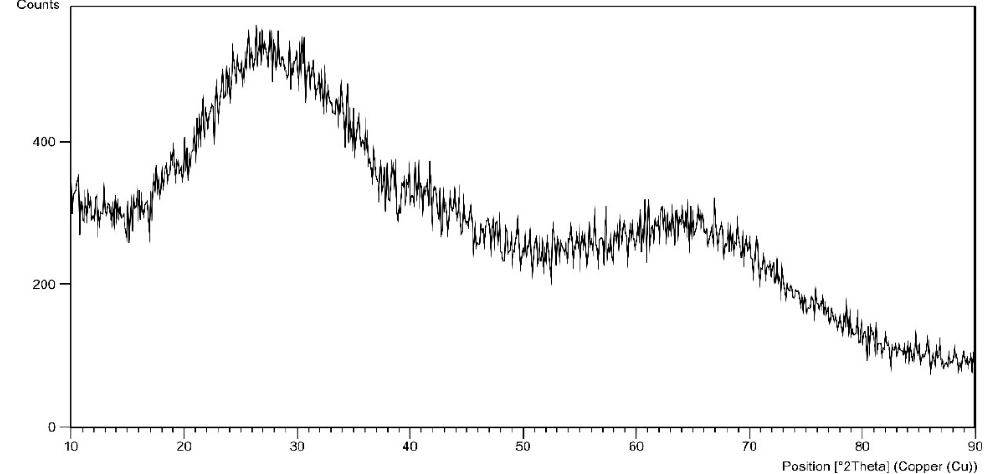
Figure 4. GIXD pattern for the angle of incidence α = 0.50° obtained for the 01K sample without modification.